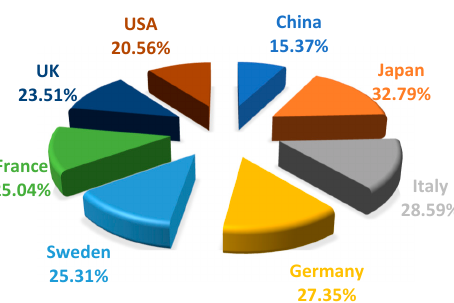
Figure 1. Distribution of the proportion of the population over 60.